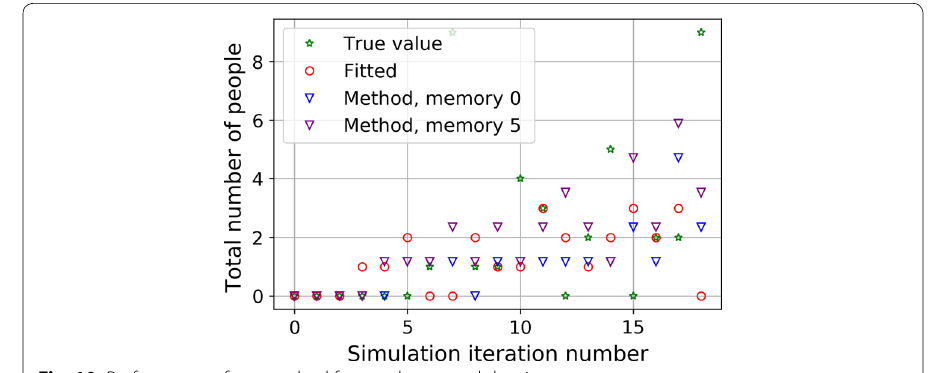
Fig. 10 Performance of our method for very low crowd density